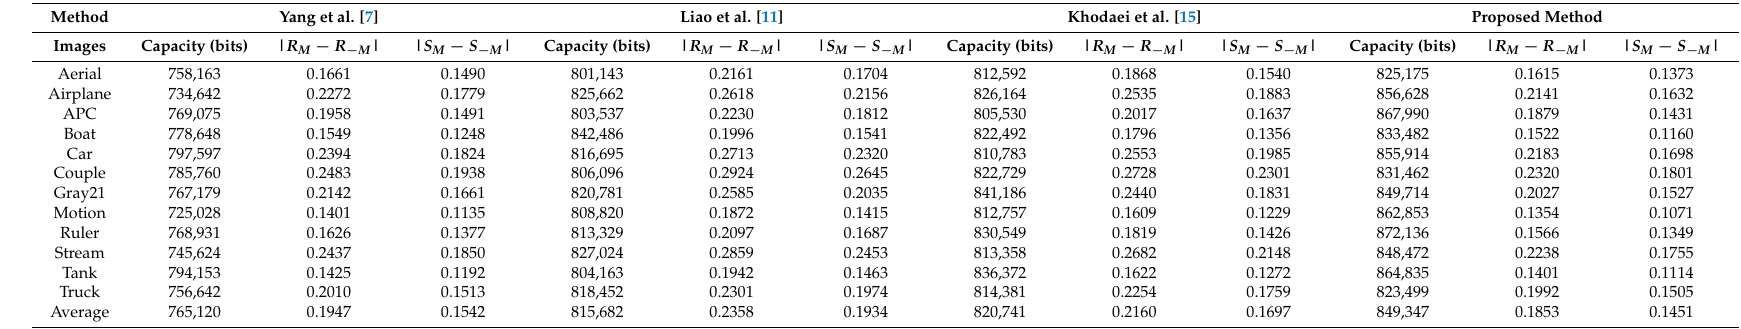
Table 6. Comparison of maximum differences in RS-steganalysis detection parameters with previous methods using USC-SIPI [24] dataset images. Method